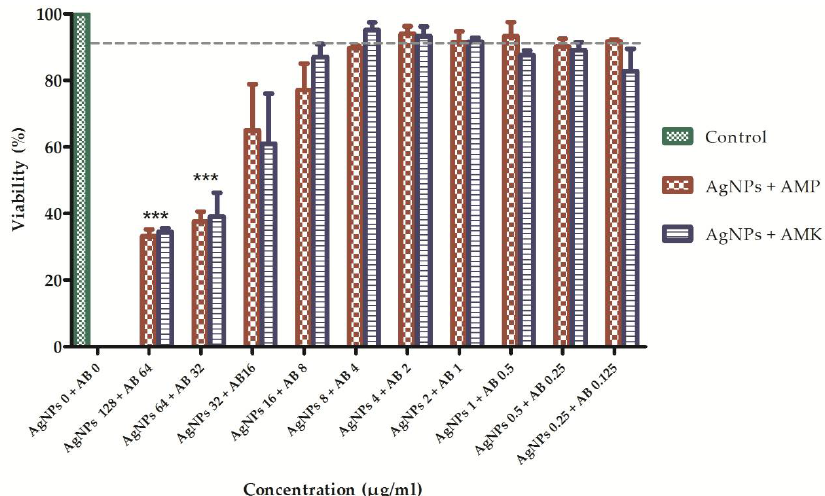
Figure 5. Viability of cells treated with combinations of silver nanoparticles and antibiotics. To measure cytotoxicity, fibroblasts were treated with increasing concentrations of AgNPs + AMP (red) or AgNPs + AMK (blue) (n = 3). Twenty-four hours after of addition of treatment cell viability was determined using MTT. Results are expressed as mean and standard deviation. * p < 0.05, ** p < 0.01, *** p < 0.001 by two-way ANOVA. Control: DMEM. AB: Antibiotic = Amikacin (AMK) or Ampicillin (AMP).